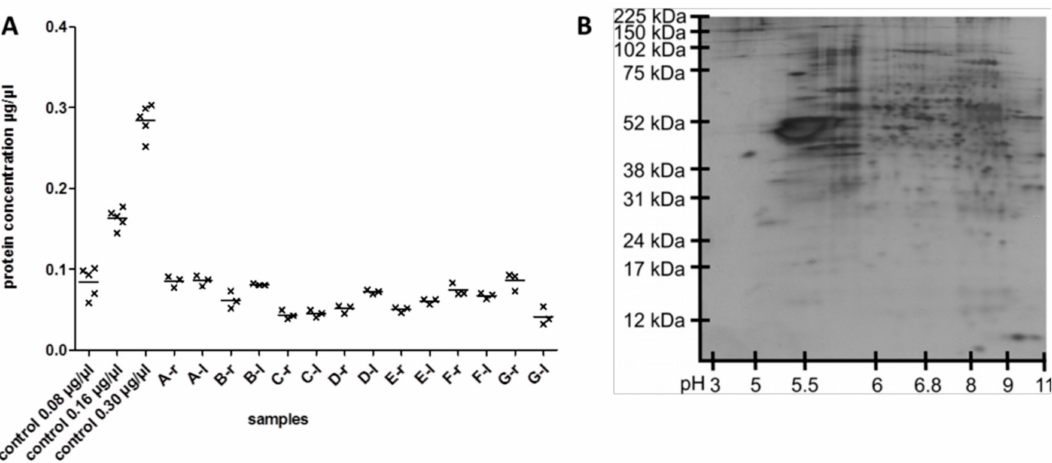
Figure 3. Protein content after membrane protein enrichment in single acute slices. ( A ) Protein concentrations after membrane protein enrichment in single slice samples. Samples were termed after the animal (letter) and originate from right or left hemispheres (r or l). Protein concentration was determined three times per sample. ( B ) Two-dimensional protein separation after membrane protein enrichment of one single acute slice demonstrated abundance of various proteins over a large protein weight and pI